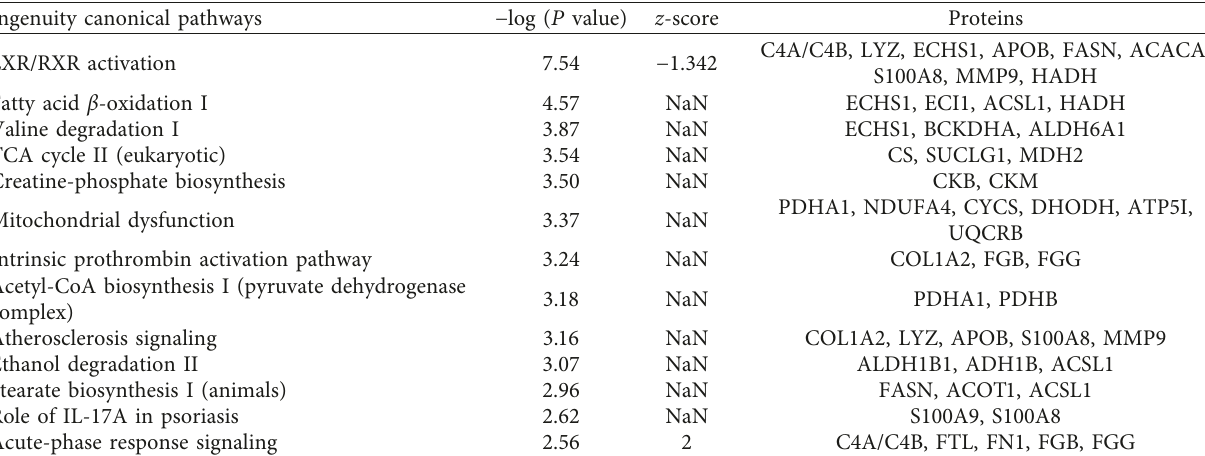
Figure 4: Ingenuity Pathway Analysis of the differentially expressed proteins. Differentially expressed proteins in VAT were characterized, and the top 13 canonical pathways were exhibited. Acute-phase response signaling was activated (red histogram). The LXR/RXR signaling pathway was inhibited (blue Table 3: Top canonical pathways and related differential proteins.